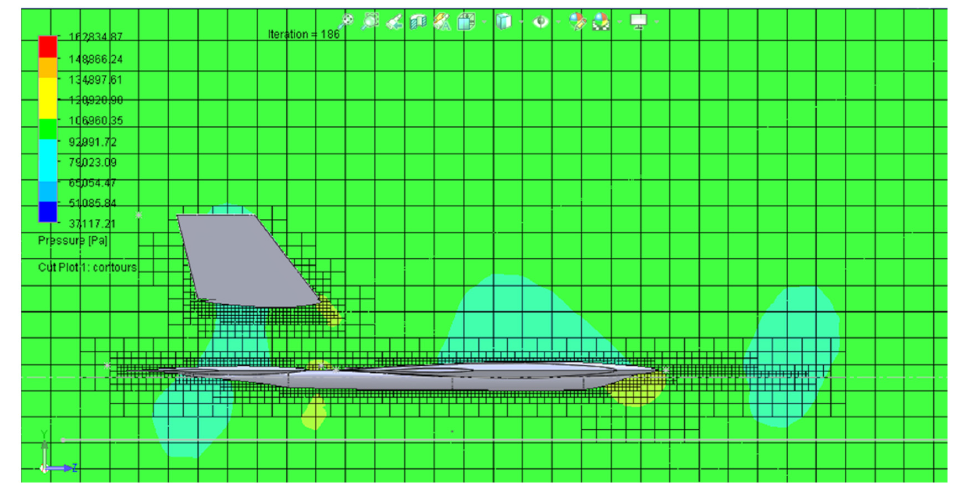
Figure 2. Cartesian mesh with impingement of the model. Impingement means that elements are adapted to the model boundary